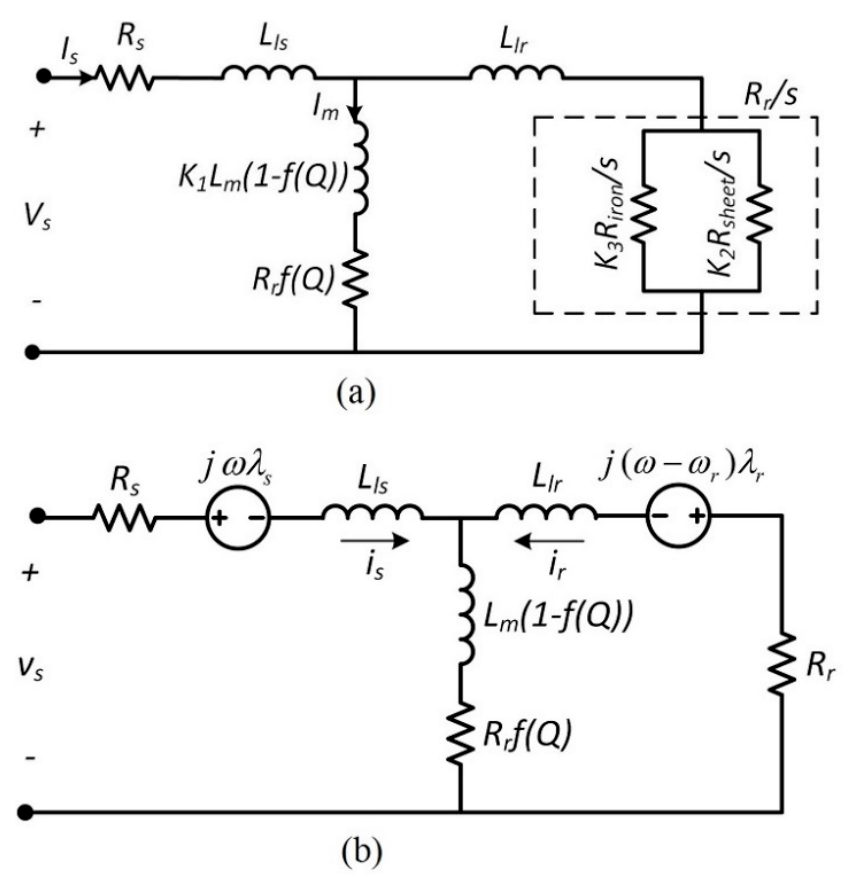
Figure 4. Proposed ( a ) steady-state and ( b ) dynamic equivalent circuit model of a LIM.